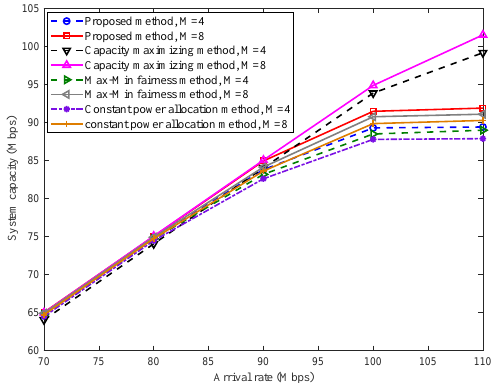
Figure 5. System capacity of different methods in Scenario